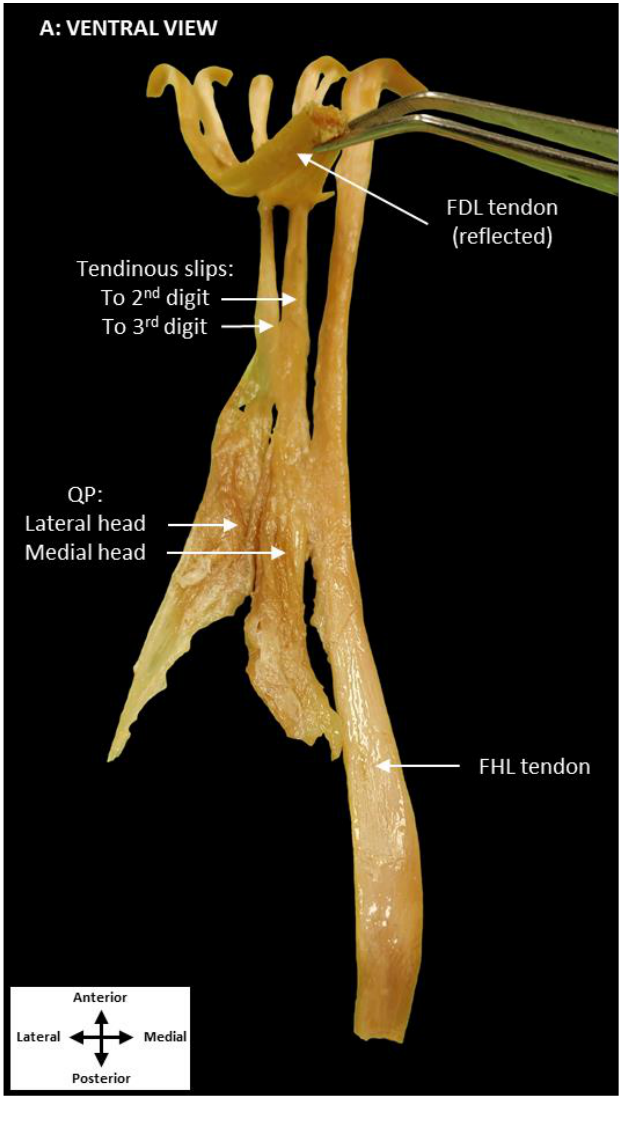
Figure 3. Dissection of QP, the tendon of FDL, and the tendon of FHL. The ventral view ( A ) shows the medial head of QP contributing to the first tendinous slip. The lateral head of QP inserts onto the second tendinous slip. Additionally, the tendinous slips to the second and third digits are attaching to the tendons of FDL. The dorsal perspective ( B ) shows the FHL tendon contributing to both the first and second tendinous slips. (Flexor digitorum longus: FDL, quadratus plantae: QP, flexor hallucis longus: FHL).